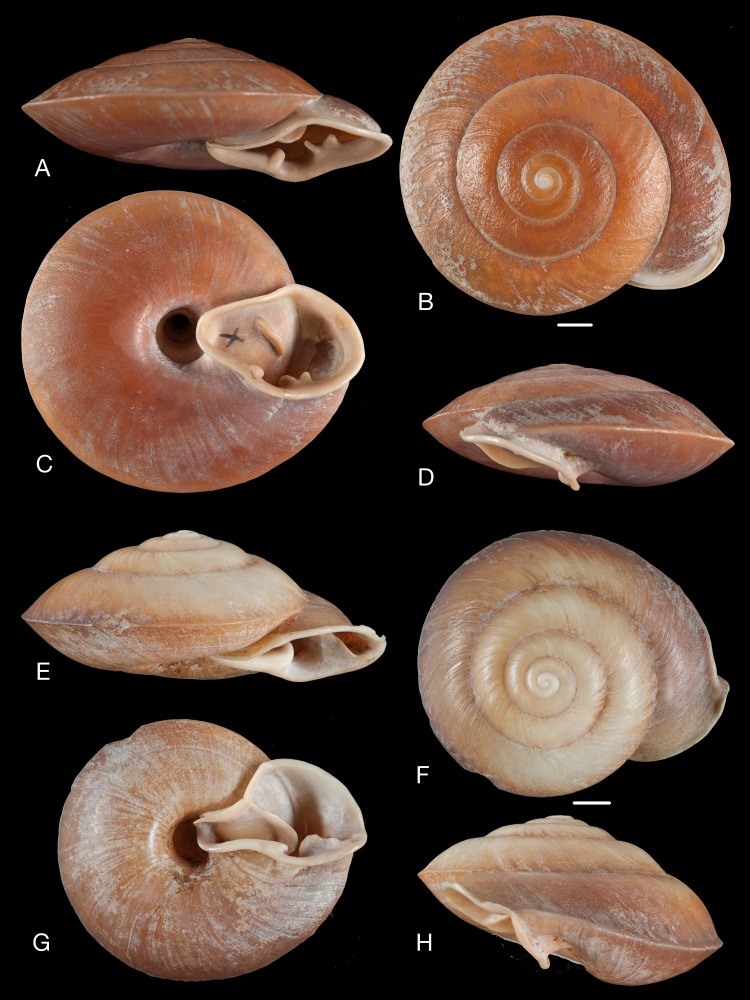
Material collected by the CCP.(A–H) Pleurodontidae. Labyrinthis raimondii (Philippi, 1867), MNCN 15.05/58495, (A) ventral view, (B) apical view, (C) umbilical view, (D) lateral view (lip); Labyrinthus otis otis (Lightfoot, 1786), MNCN 15.05/13957, (E) ventral view, (F) apical view, (G) umbilical view, (H) lateral view (lip). Scale line 5 mm.